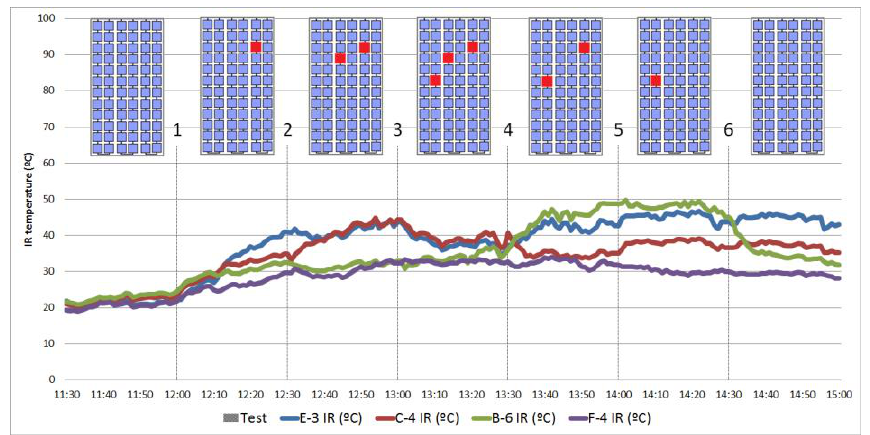
Figure 12. Infrared (IR) thermographic camera temperatures on the front side of the PV module in test 2.